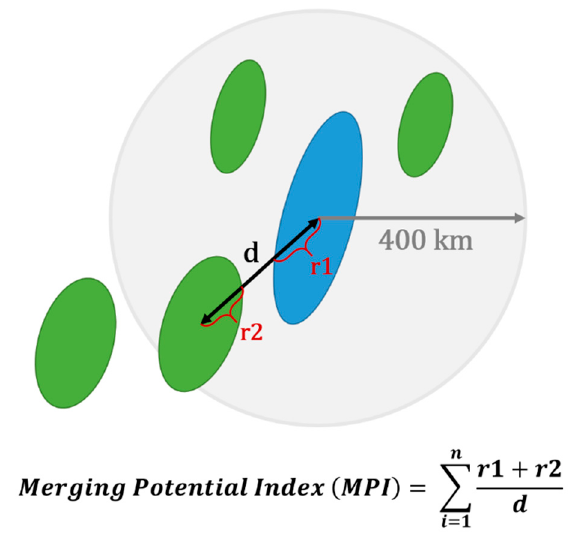
Figure 12. Schematic diagram demonstrating the calculation of the proposed merging potential index (MPI). For a targeted MCS sample (denoted by the blue oval), its MPI is calculated as the sum of its fractional distance(s) with other MCS sample(s) within its 400 km range (denoted by green ovals having a centroid within the gray circle). The calculation formula is given in the diagram ( n = 3 in this example). The centroid of an MCS sample is determined as the average longitude and latitude of the satellite pixels belonging to the identified MCS area. An MCS sample has a higher MPI when it has more and closer MCS samples and thus greater potential to undergo merging